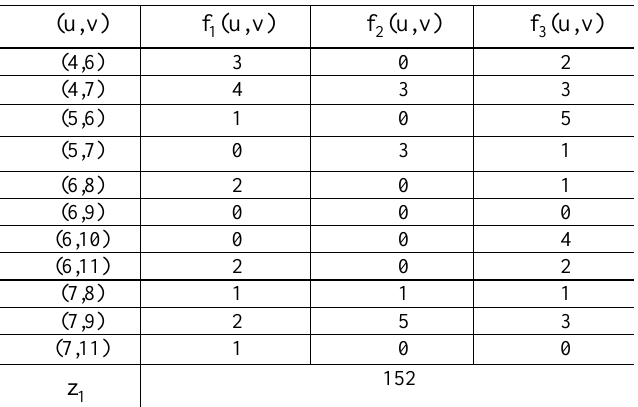
Table 1: Optimal flows of products